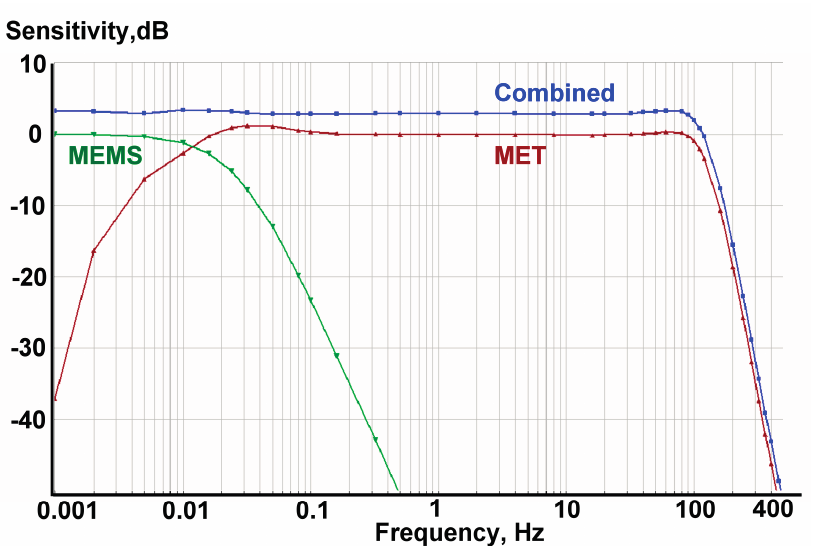
Figure 8. Simulated amplitude response. Overall system response (blue) is raised by +3 dB for better visualization. Red is a filtered MET sensor response, while green is that for MEMS.